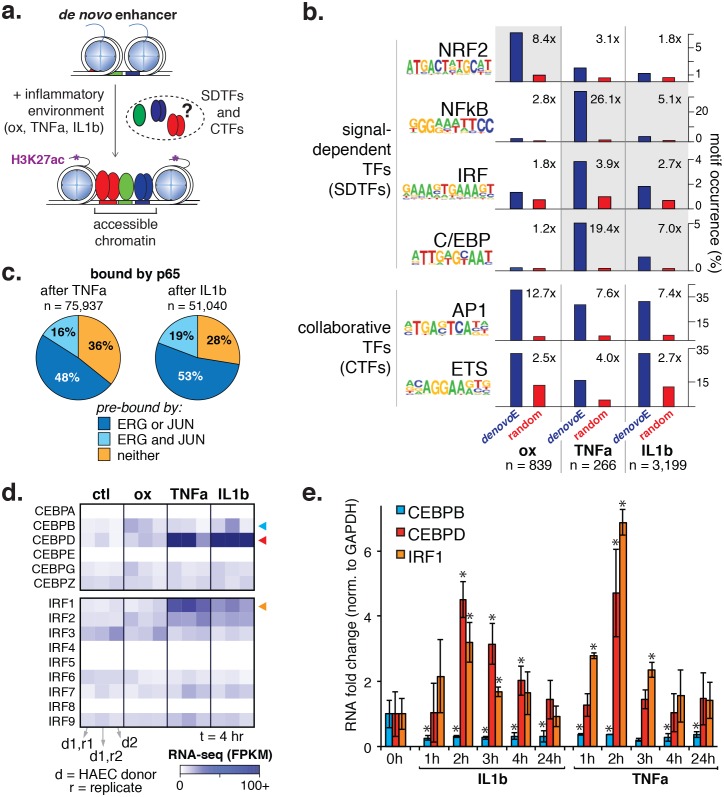
Inflammatory signals activate enhancer-like elements with distinct motifs and suggest that CEBP and IRF members mediate responsiveness to TNFα and IL1β.(a) A schematic for de novo enhancer activation by combinations of signal-dependent and collaborative TFs. (b) Enrichments of the NRF2, NFκB, IRF, C/EBP, AP1, and ETS motifs (y-axis) are shown for de novo enhancer sets activated after 4 hr by either 40 µg/ml oxPAPC (ox), 10 ng/ml TNFα, or 2 ng/ml IL1β (x-axis). Blue bars show the percent of de novo enhancers containing the motif and red bars indicate the percentage of GC-matched random genome sequence containing the motif. Motifs were considered within 200 basepair windows of enhancers. (c) ChIP-seq analysis of p65-binding sites shows regions of the genome that are co-bound by p65 and JUN, p65 and ERG, all three, or solely p65 post treatment by 10 ng/ml IL1β and 2 ng/ml TNFα treatment. (d) Gene expression, measured by RNA-seq is shown by heatmap for TFs of the C/EBP and IRF families. Expression values are shown from two HAEC donors and replicate samples. (e) RT-qPCR analysis shows CEBPB, CEBPD, and IRF1 expression from 0 to 24 hr post treatment by 10 ng/ml IL1β and 2 ng/ml TNFα treatment. Plotted are mean ± S.D., experiment performed with biological triplicates. * represents p<0.05 by t-test. More related data in Figure 5—figure supplements 1–4.DOI:
http://dx.doi.org/10.7554/eLife.22536.01710.7554/eLife.22536.018Figure 5—source data 1.Motif enrichments in 100 bp sequences defined by promoter-distal (≥3 kb) loci gaining ATAC-seq and H3K27ac upon 4 hr oxPAPC, TNFα, and IL1β treatments.